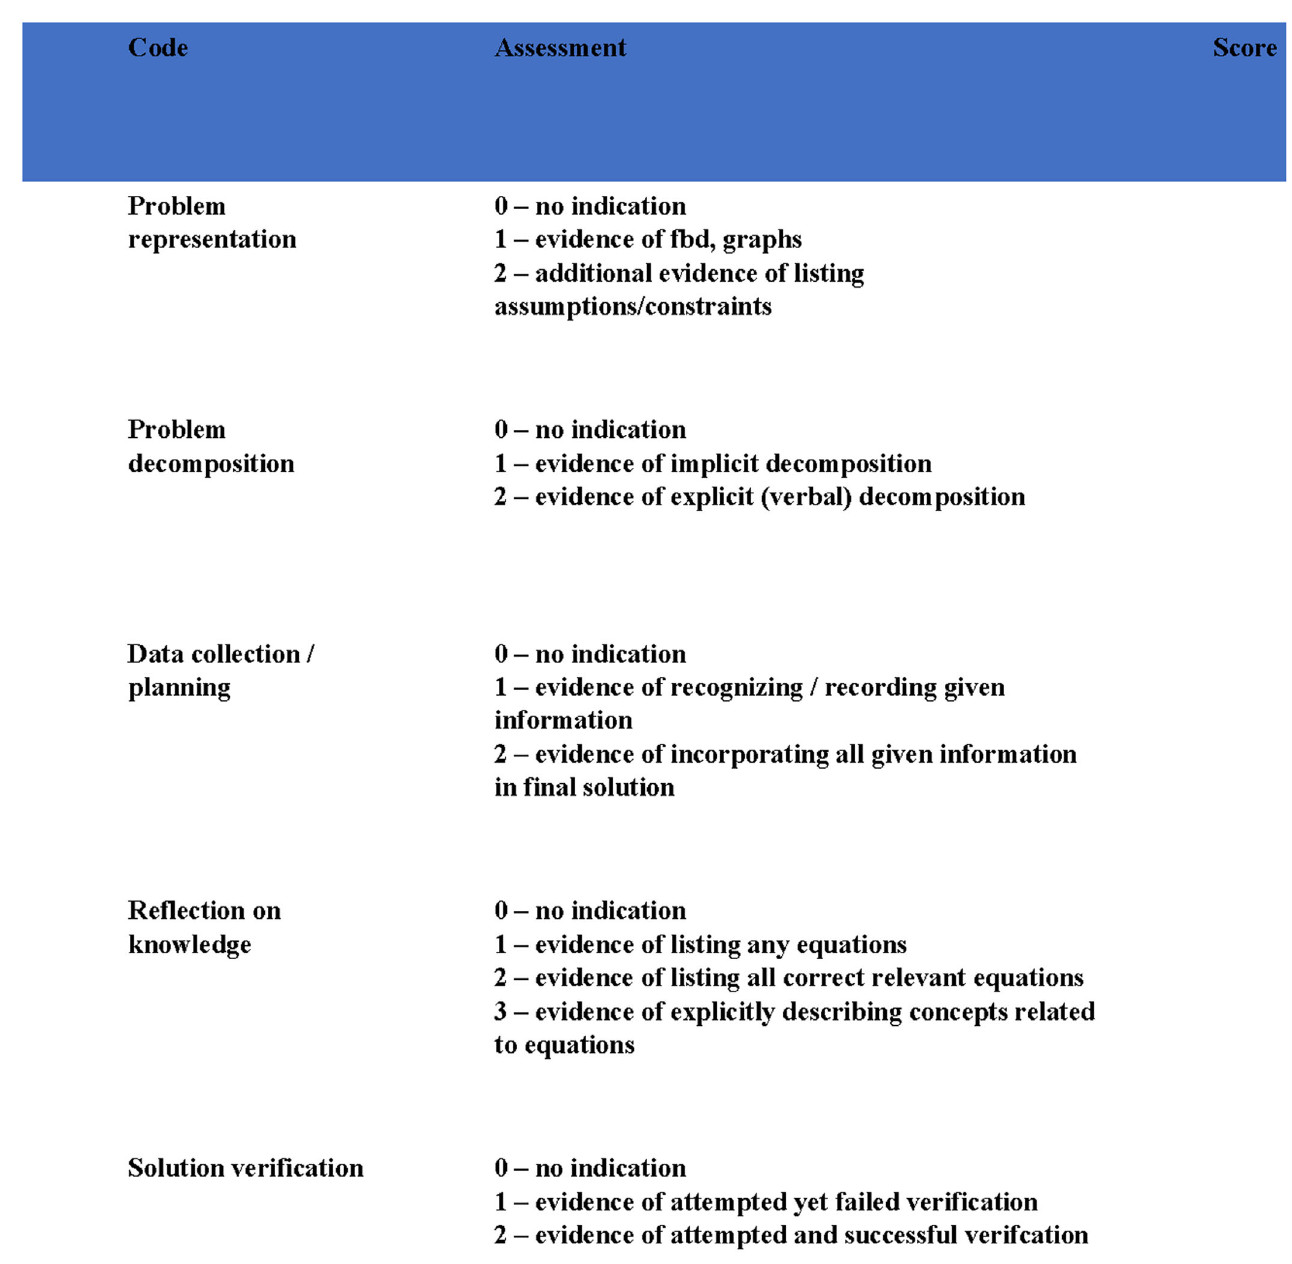
FIG. 7. Rubric for Atwood machine